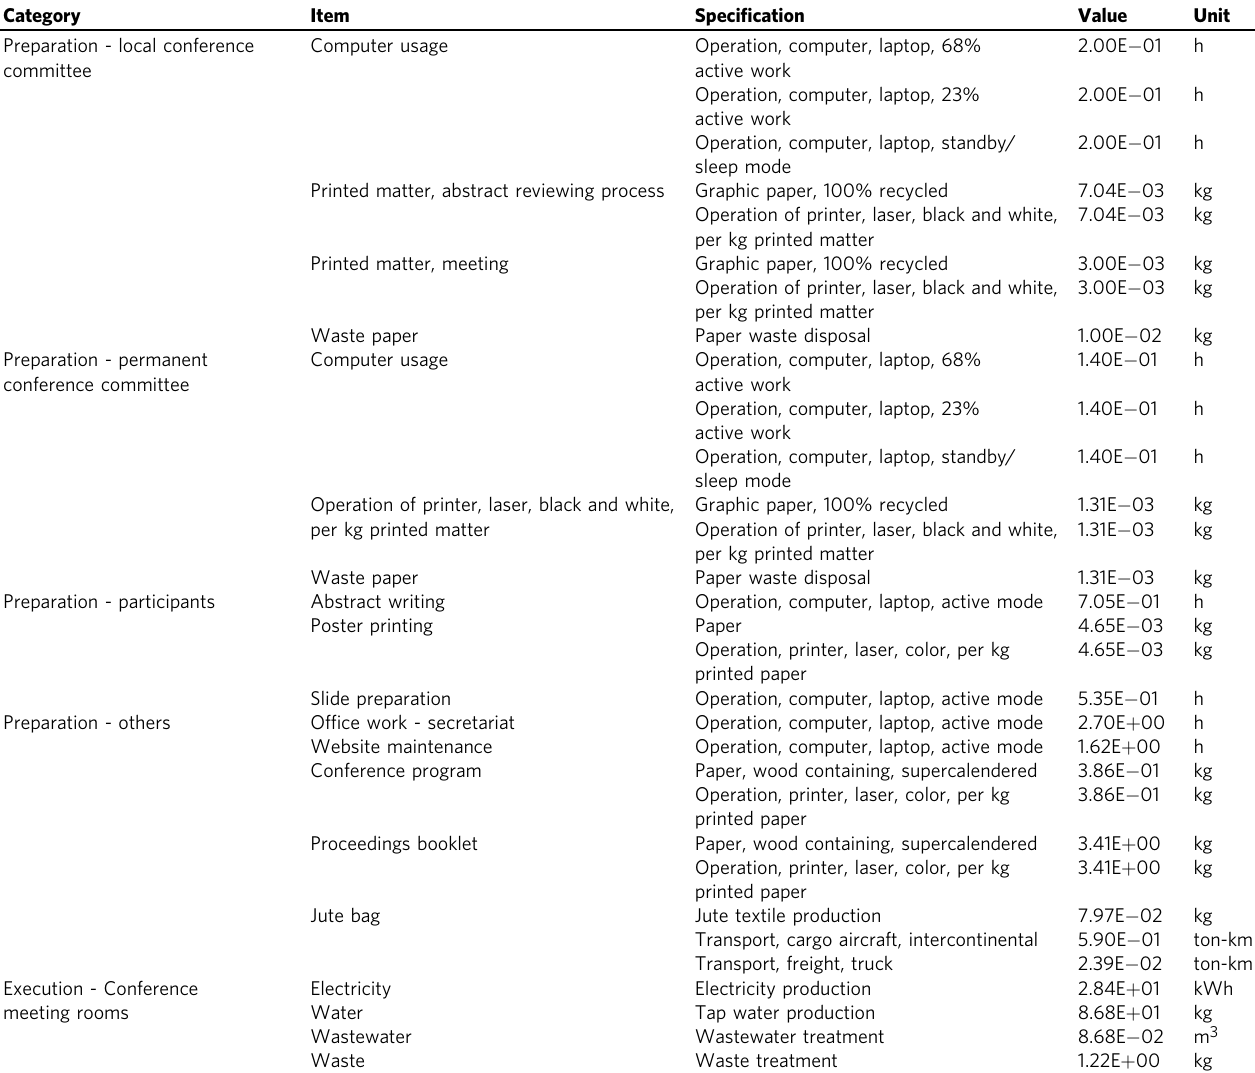
Table 4 Material and energy consumption of preparation and execution 6,13,50